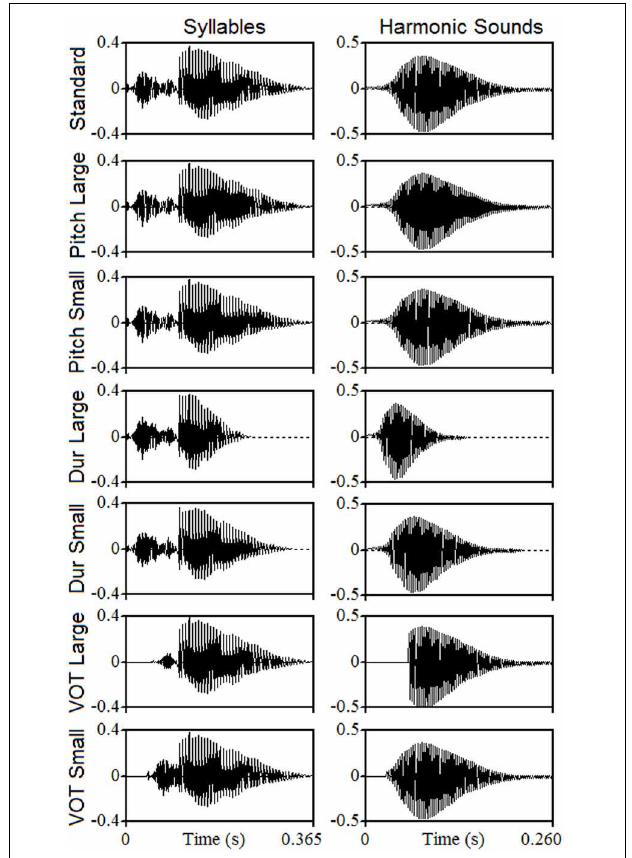
FIGURE 1 | Waveforms of the auditory stimuli. The first row shows the two standard stimuli: the Mandarin “Cha” syllable (left column) and the note “Mi3” of a clarinet harmonic sound (right column). The other rows show the different deviants. Waveforms are temporally synchronized to the first pulse of the harmonic sound and of the